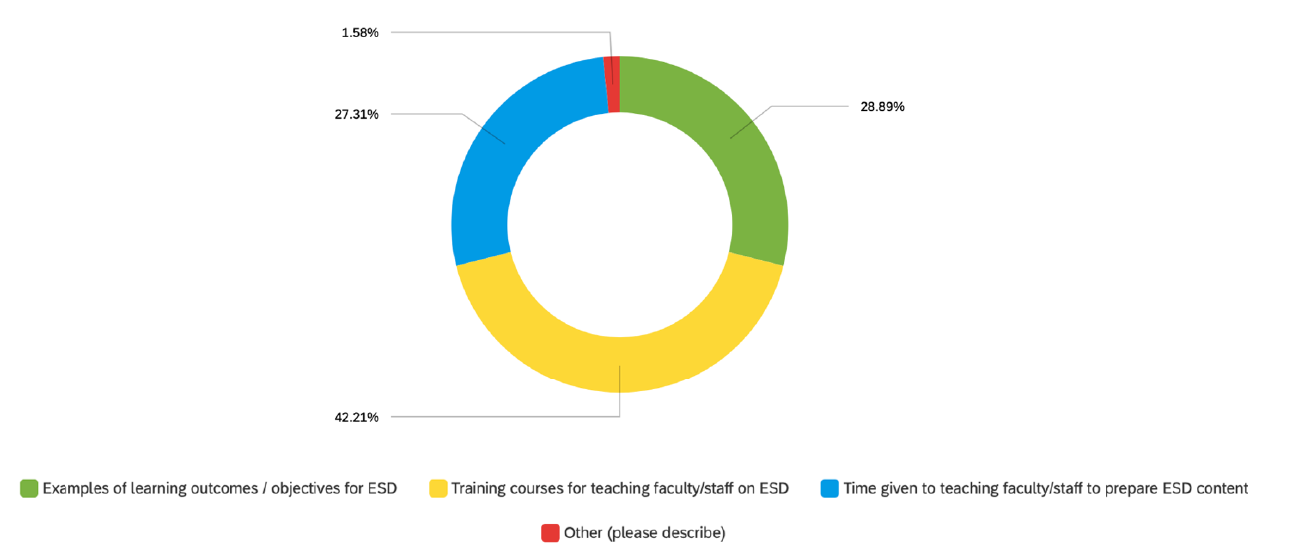
Figure 3. Faculty’s enablers to embedding environmentally sustainable dentistry (ESD) in the dental curricula.